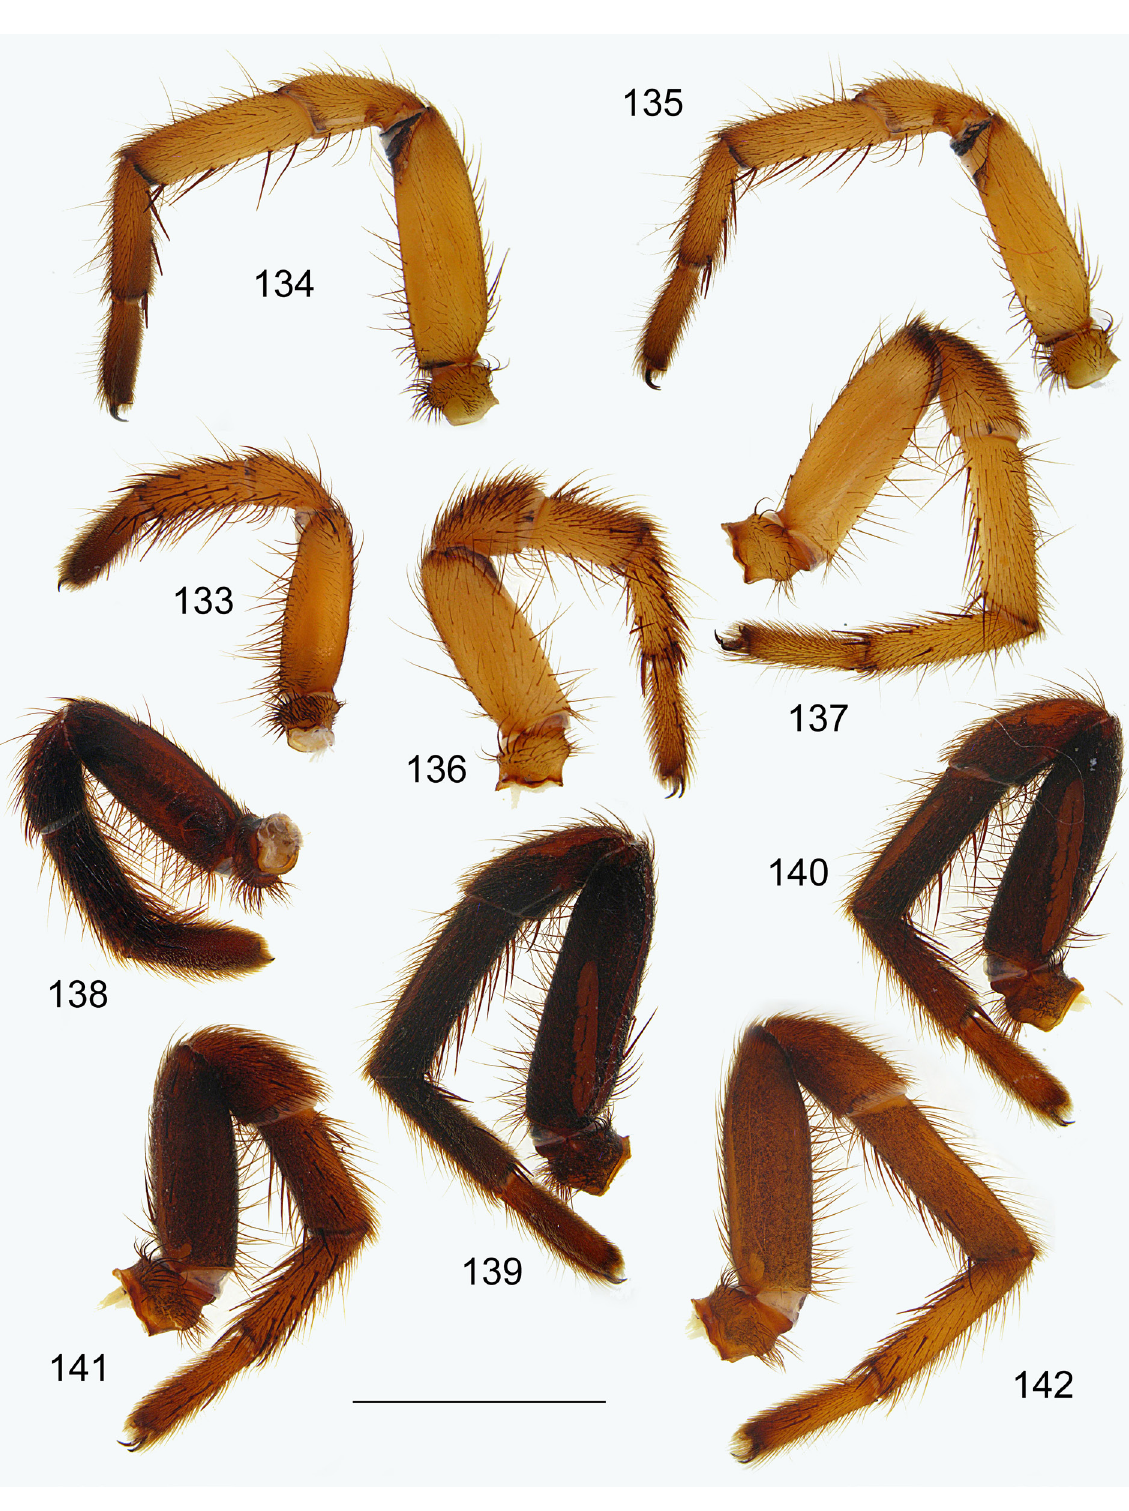
Figs 133–142. Anemesia sogdiana sp. nov. (133 –137) and A. incana Zonstein, 2001 (138 –142), ♀♀, palps and legs I–IV, retrolateral views. 133, 138 . Palp. 134, 139 . Leg I. 135, 140 . Leg II. 136, 141 .